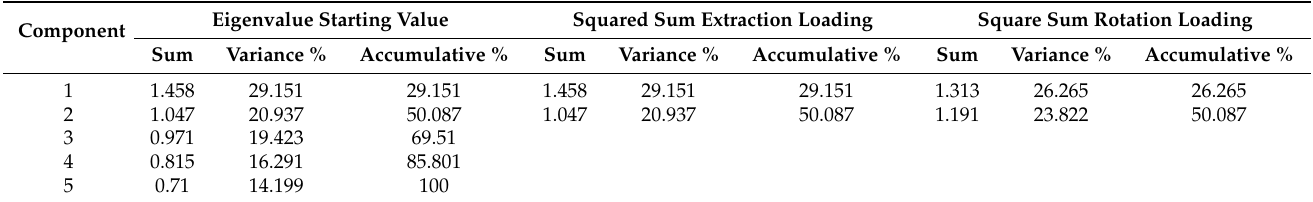
Table 15. Total interpretation variance.